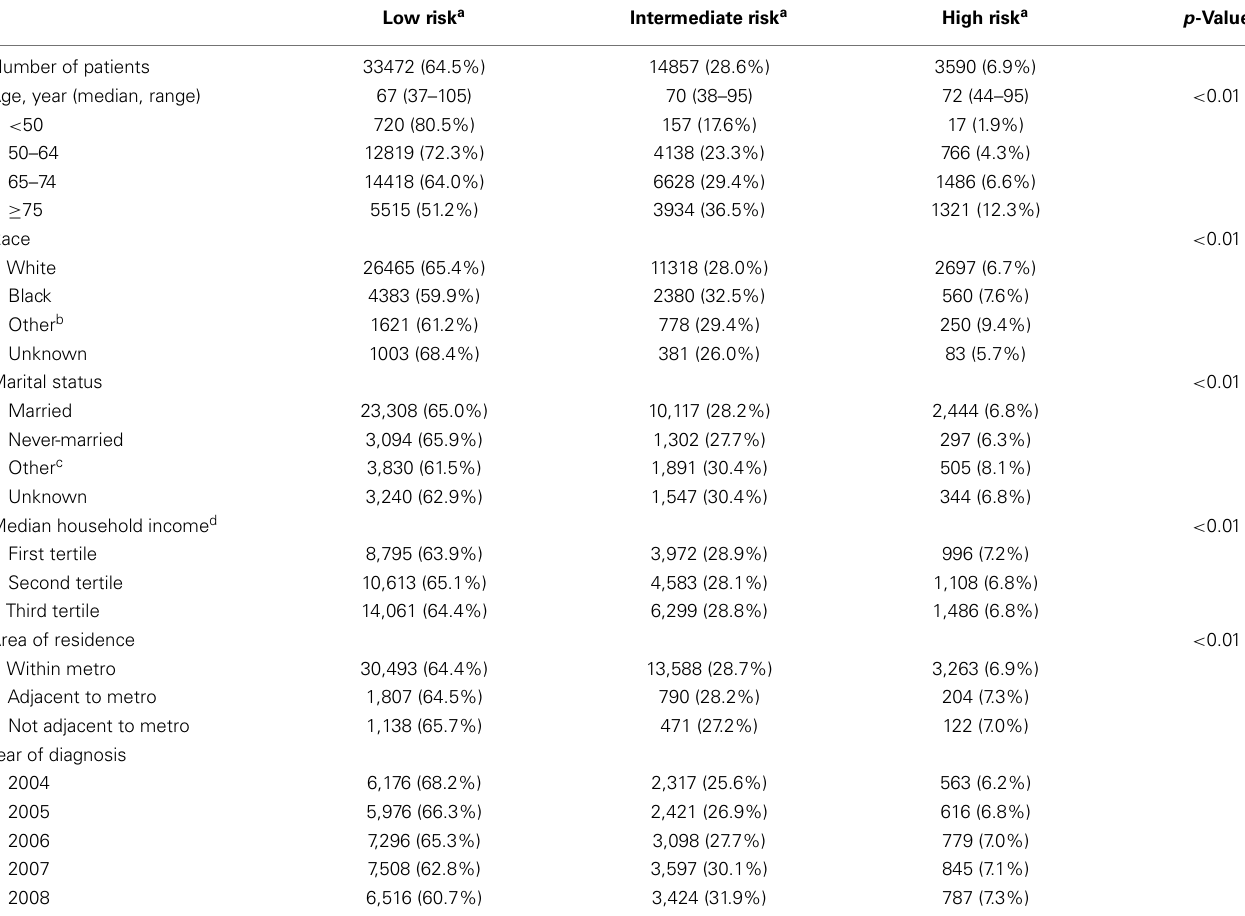
Table 5 | Characteristics of 51,919 men with PSA < 10ng/ml stageT1cN0M0 prostate cancer